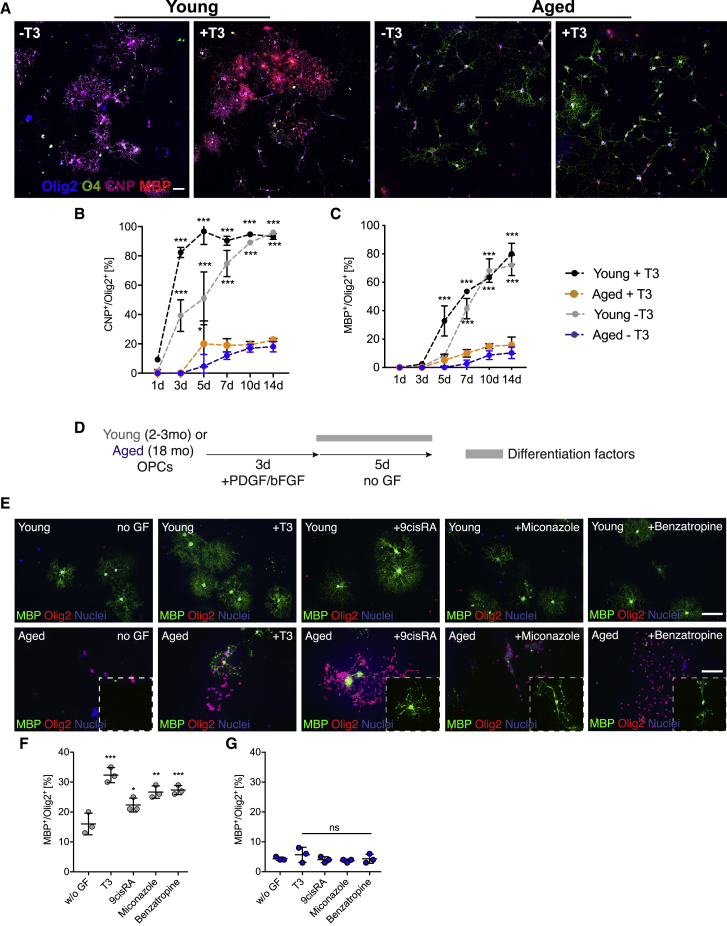
OPCs Lose Their Inherent Capacity for Differentiation and Their Responsiveness to Differentiation Factors with Aging(A) Representative images of young adult (2–3 months old) and aged OPCs (20–24 months old) differentiated in the absence of growth factor or in the presence of T3. Increasing maturity was visualized using O4 (early), CNPase (intermediate), and MBP (mature), immunocytochemical markers of the oligodendrocyte (OL) lineage. Scale bars, 50 μm.(B and C) Quantification of cells over time in culture: CNPase+/Olig2+ cells (B) and MBP+/Olig2+ cells (C). Statistical significance was determined using two-way ANOVA repeated measurements followed by Dunnett’s post test to compare each group against “aged T3.” All data are presented as mean ± SD (n = 3 biological repeats).(D) Schematic of the experimental design.(E) Representative images of the differentiation assay performed with young and aged OPCs. Newly formed oligodendrocytes were identified as MBP+/Olig2+ cells. Scale bars, 50 μm.(F and G) Quantification of the differentiation assay for young (F) and aged OPCs (G). n = 3 biological replicates for each group, one-way ANOVA with Dunnett’s multiple comparisons test for each group against the group differentiating in the absence of growth factors (“w/o GF”).Error bars represent SDs. ∗p < 0.05, ∗∗p < 0.01, ∗∗∗p < 0.001.See also Figures S1–S3.